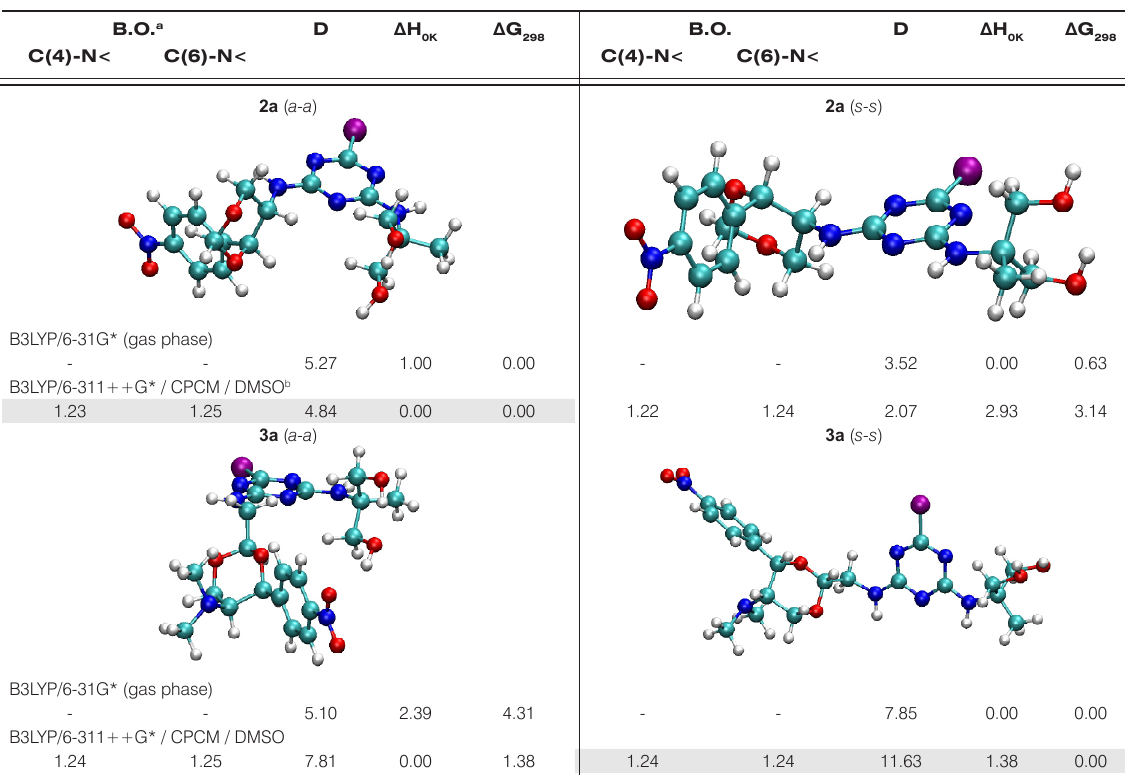
Table 3. Bond orders (B.O.), dipole moments µ (D), ZPE corrected relative energies Δ H of frozen rotamers ( a - a ) and ( s - s ) of compounds 2a and 3a